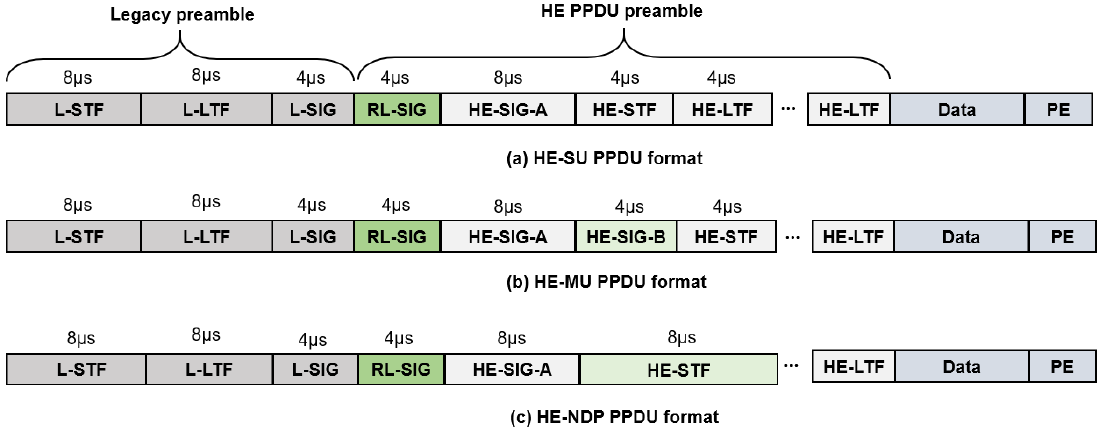
Figure 3. IEEE 802.11ax PPDU frame